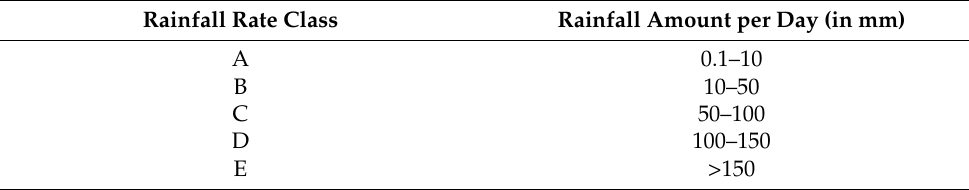
Table 2. Classification of rainfall rate based on rainfall amount per day (mm)